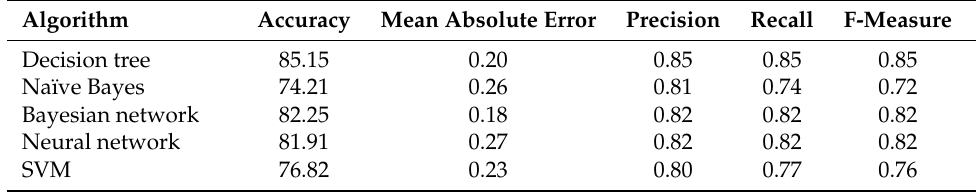
Table 7. Case study 2 results for summation division approach using percentage split.